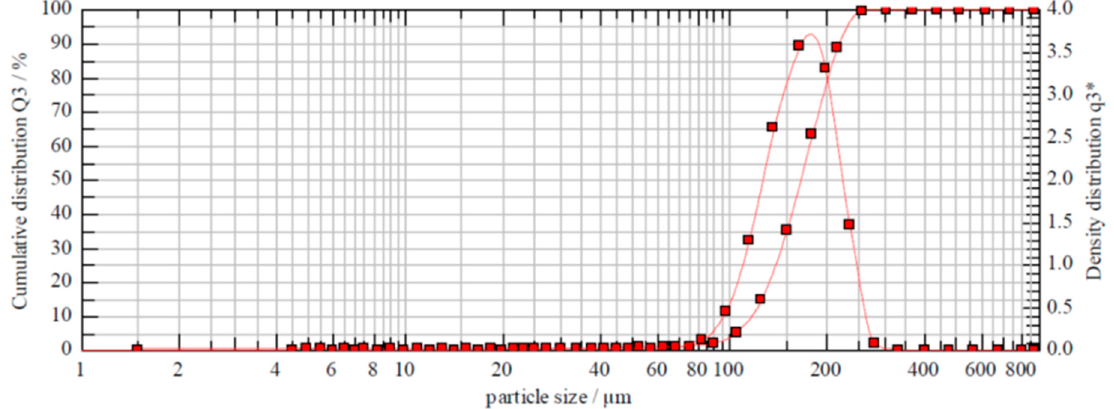
Figure 2. Particle size distribution (PSD) of BR44 . The figure shows the cumulative and density distribution of one batch of BR44 as a representative example. X 10 = 116 µm, X 50 = 166 µm, X 90 = 220 µm. Table 1. Biophysical properties of BR44 . Data represent the mean of six different batches of BR44 . Particle Size Distribution (PSD) (µm) Concentration (g/mL) Theoretical Surface (cm 2 /g) X 10 X 50 X 90 0.034 ±